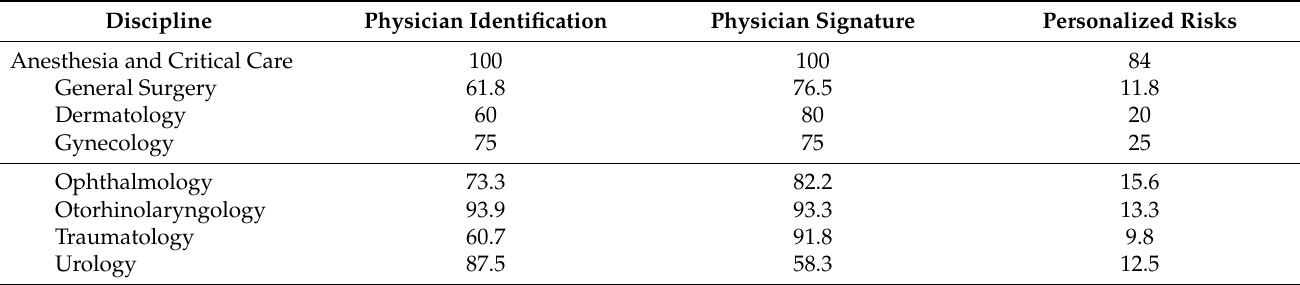
Table 6. Percentage of compliance with the most significant